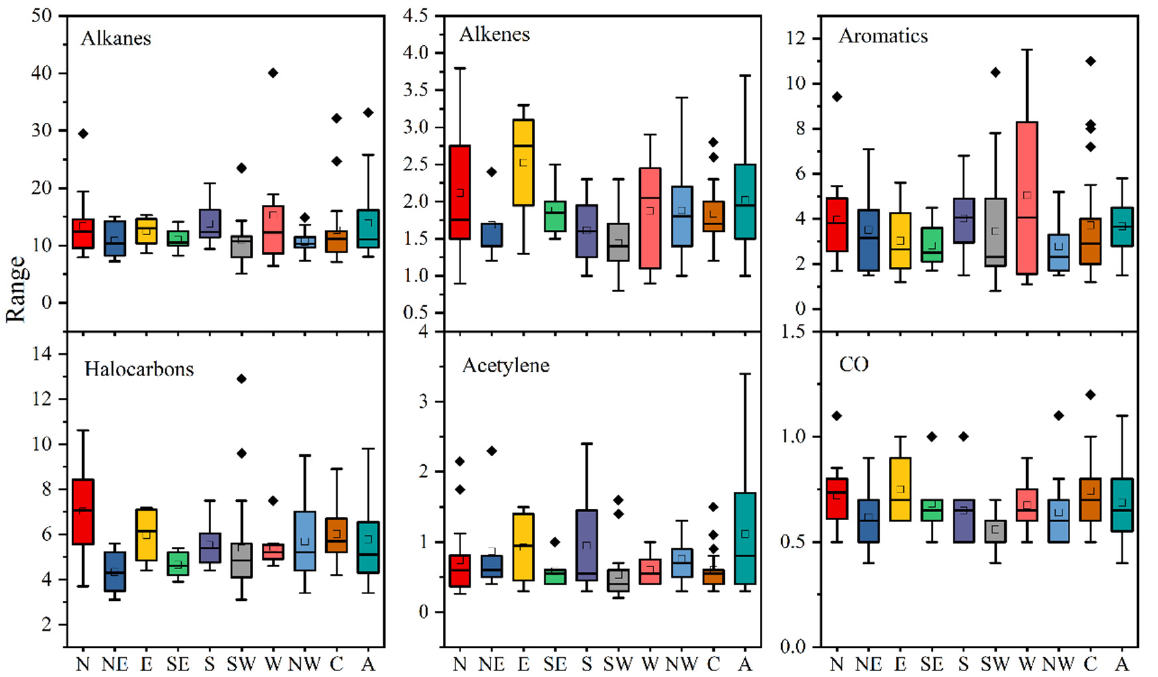
Figure 3. Variations of alkanes (ppbv), alkenes (ppbv), aromatics (ppbv), halocarbons (ppbv), acetylene (ppbv), CO (mg/m 3 ) under the ten atmospheric circulation types; The box represents the 25%~75% value, horizontal line; The tlack diamond represents abnormal value.